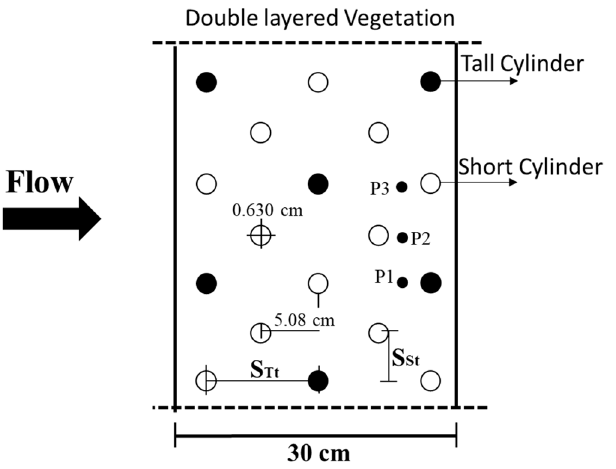
Figure 1. Experimental geometry of [34], where the top view of the geometry is shown and three selected positions are selected (P1, P2, P3).